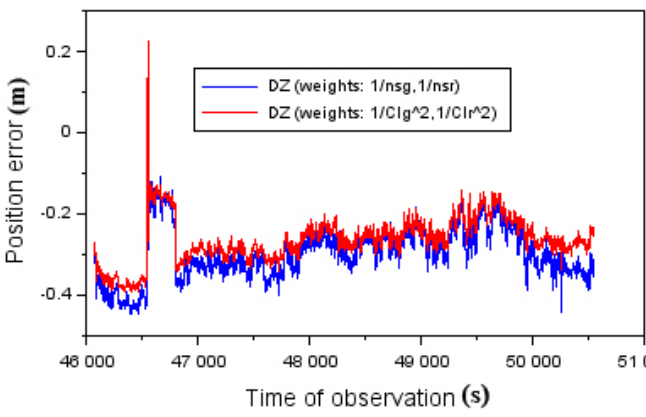
Figure 15. Position errors along the Z -axis .